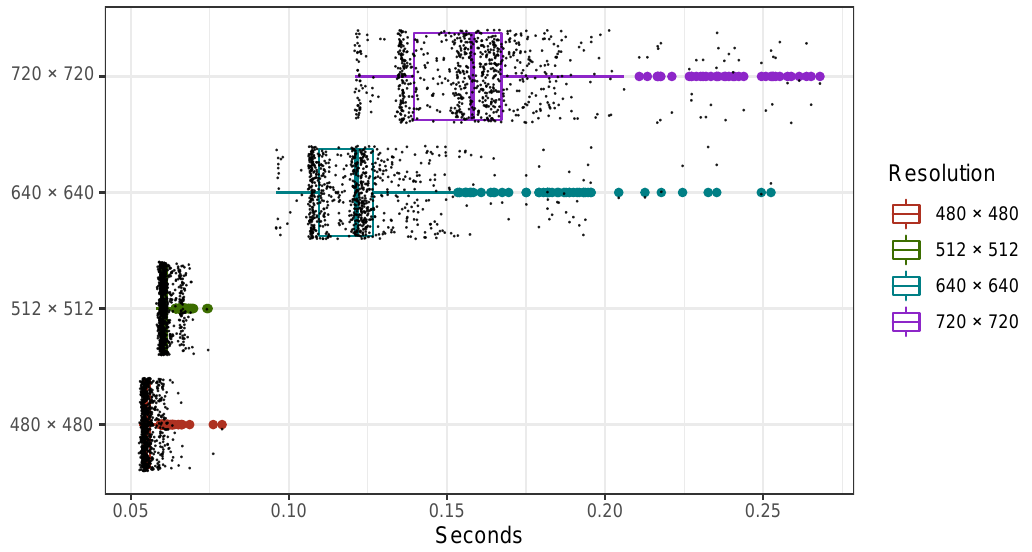
Figure 9. Processing times of the proposed approach for different image